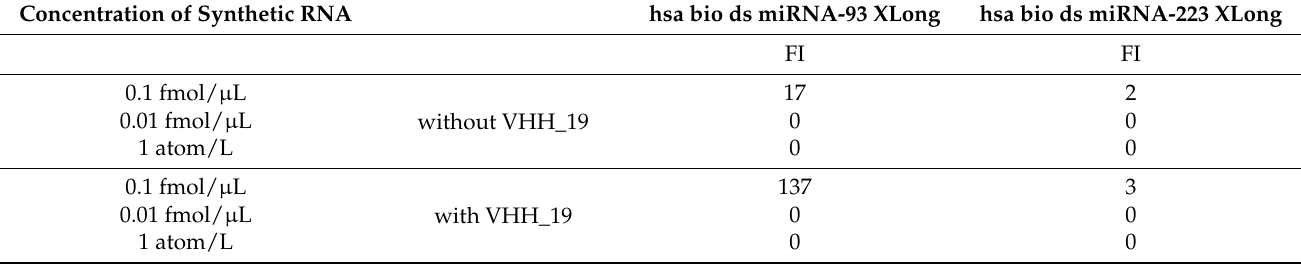
Figure A1. Schematic overview of the detection of miRNA with the anti-nucleic binder VHH_19. The miRNA sample (synthetic miRNA or isolated from human serum) was hybridized with the biotin-labeled complementary probe. The complex of biotin-labeled chimeric miRNA-probes was incubated with VHH_19 coupled dynabeads ® . The detection of bound miRNA probes to VHH_19 occurred by the binding of Phycoerythrin-labeled SAV (SAV-PE) to the biotin. Table A1. Detection of synthetic miRNA with VHH_19 via bead-based assay. FI stands for fluores- cence intensity.